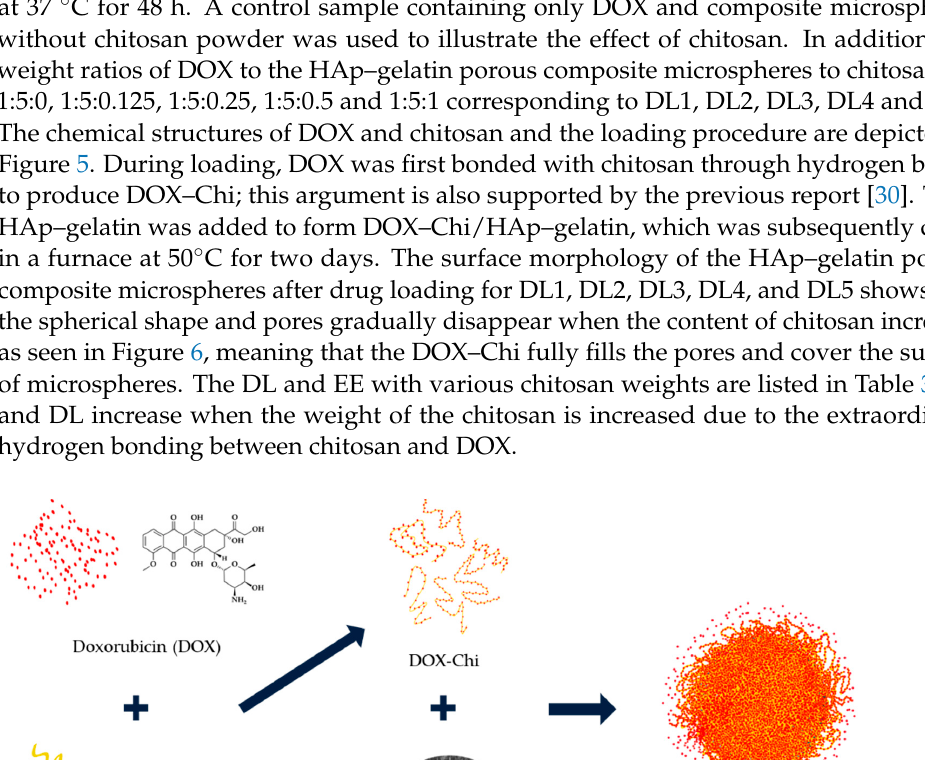
hydroxyls, then insert into the pores of HAp–gelatin through blending, and finally form the DOX–